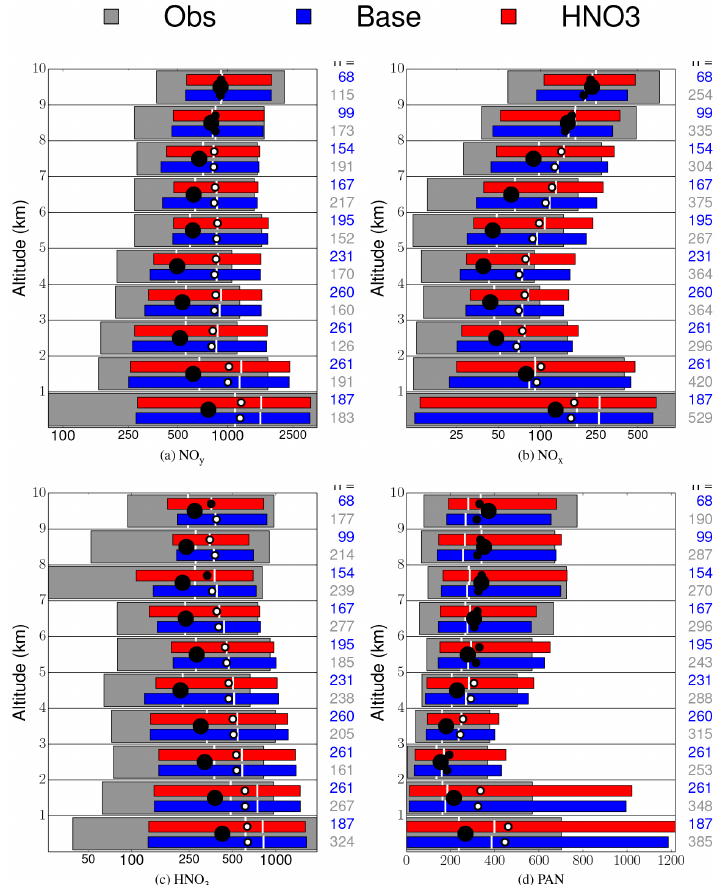
Figure A1. Same as Fig. 2 for concentrations instead of NO y